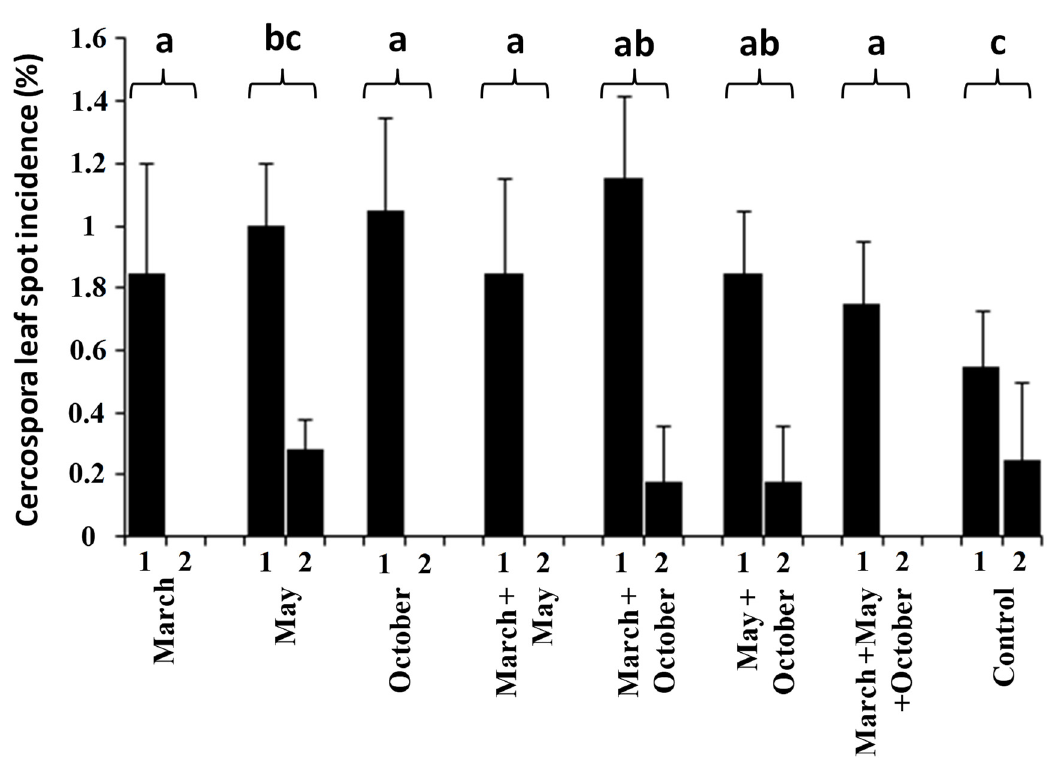
Figure 4. Incidence of cercospora leaf spot of olive (CLSO) at the beginning (May 2003) and at the end (May 2004) of Trial II for each fungicide application timing. All olive trees were treated with copper oxide (Nordox ® super 75). Columns represent the average of the evaluations conducted in 14 olive trees. Vertical bars are the standard error of the means. Annual treatment times with the same letter did not show differences in reduction in CLSO incidence among the evaluations according to Fisher´s protected LSD test at P = 0.05.